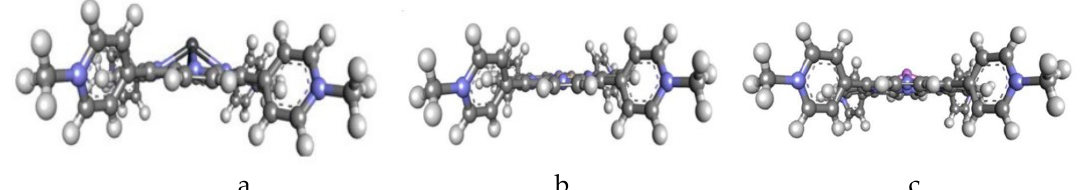
Figure 2. Visualization of the optimized structure of TMPyP complexes with the metal ions ( a ) Pb 2+ , ( b ) Cd 2+ , and ( c ) As 3+ , where ( a , c ) are sitting-atop metalloporphyrins and ( b ) is a regular metalloporphyrin.